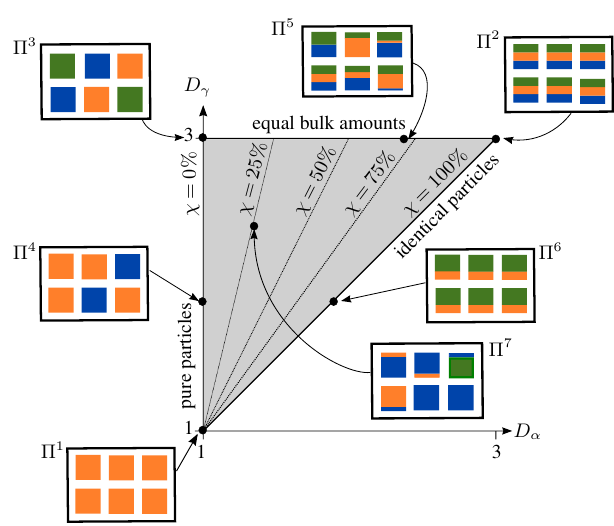
Fig. 25: Diversity and mixing state evolution for all particles in the urban plume case. (a) Distribution of per-particle di- versity D i as a function of time. (b) Time series of average particle diversity D ↵ , population diversity D  , and the mix- ing state index  .